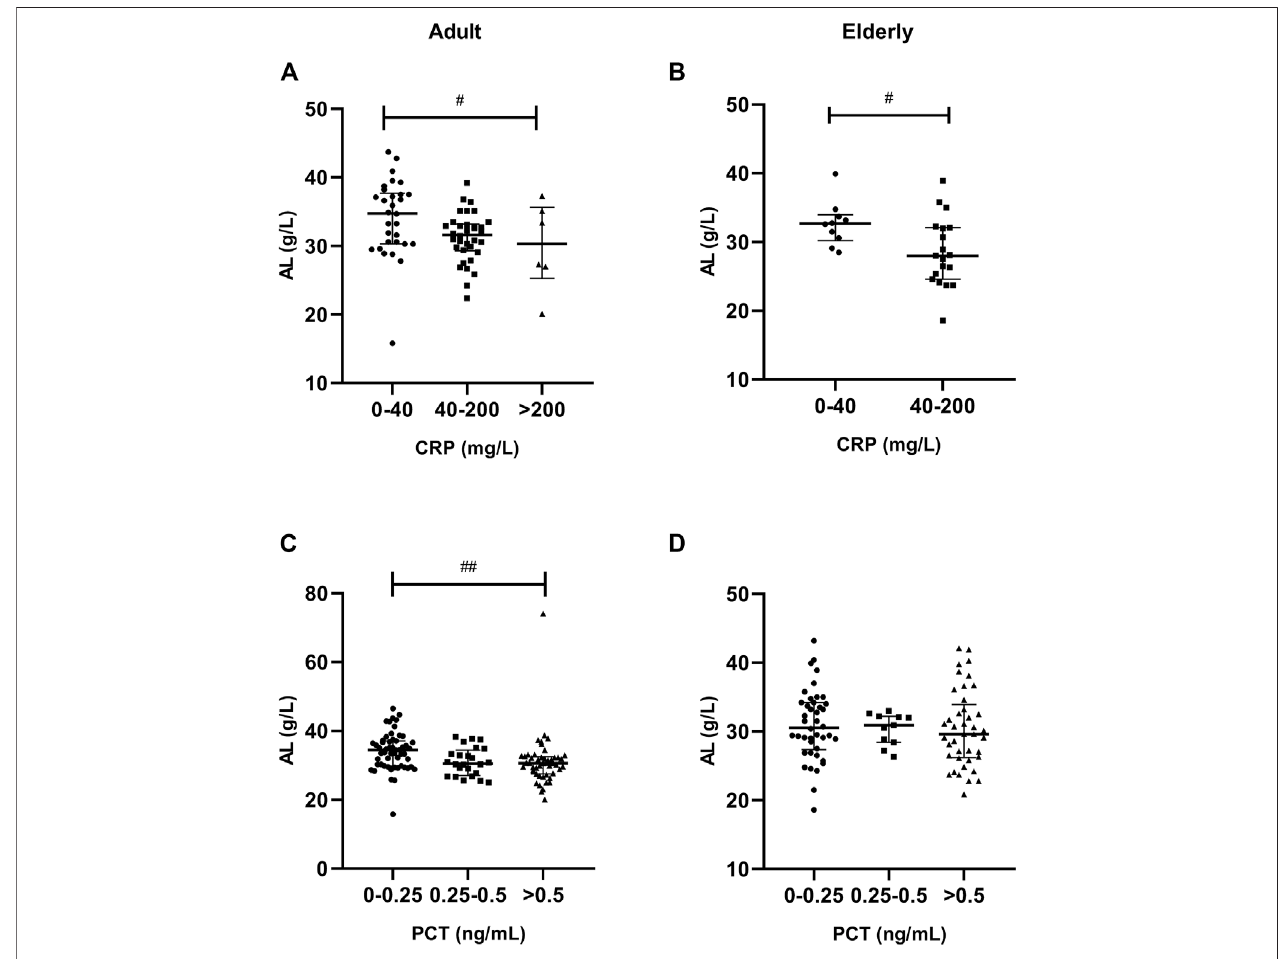
FIGURE5| Association ofCRPand PCTplasmalevels withalbumin (AL)inadult and elderly patients. (A,B) DistributionofALaccordingtoCRP. (C,D) Distribution of AL according to PCT. # p < 0.05, ## p < 0.01.